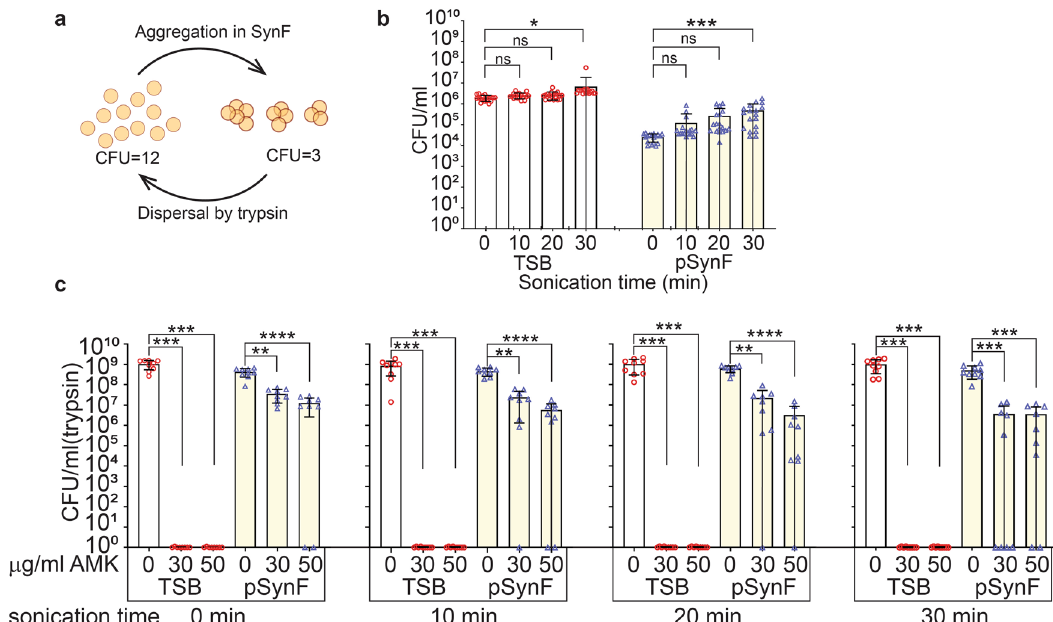
Fig. 2 Water bath sonication causes slight dispersal of aggregates, with minimal increases in antibiotic sensitivity. a Diagram of S. aureus aggregation and dispersal demonstrating that aggregation causes a decrease in CFU. With dispersal, CFU (trypsin) approximates the CFU that would be obtained in a non-aggregating medium. b MSSA CFUs recovered in TSB or pSynF after increasing times of sonication in a water bath. TSB is presented as a control. The 30 min sonication results in the greatest dispersal of aggregates (increased CFU/ml). c Antibiotic (AMK) sensitivity of MSSA cultures in TSB or pSynF that were sonicated in a water bath sonicator for up to 30 min. Data are presented as mean ± standard deviation. Symbols indicate individual points and scatter of data. For each bar b , n = 17 (TSB, 20 min, 30 min; pSynF, 10 min, 30 min) or 18 (TSB, 0 min, 10 min; pSynF, 0 min, 20 min), or c , n = 9. Individual data points are shown as open, colored symbols. Normality was checked using Kolmogorov – Smirnov test. Comparisons were done using b ordinary ANOVA for multiple comparisons or c Kruskal – Wallis test for multiple comparisons. ns, P > 0.05; * P < 0.05; ** P < 0.01; *** P < 0.001; **** P <